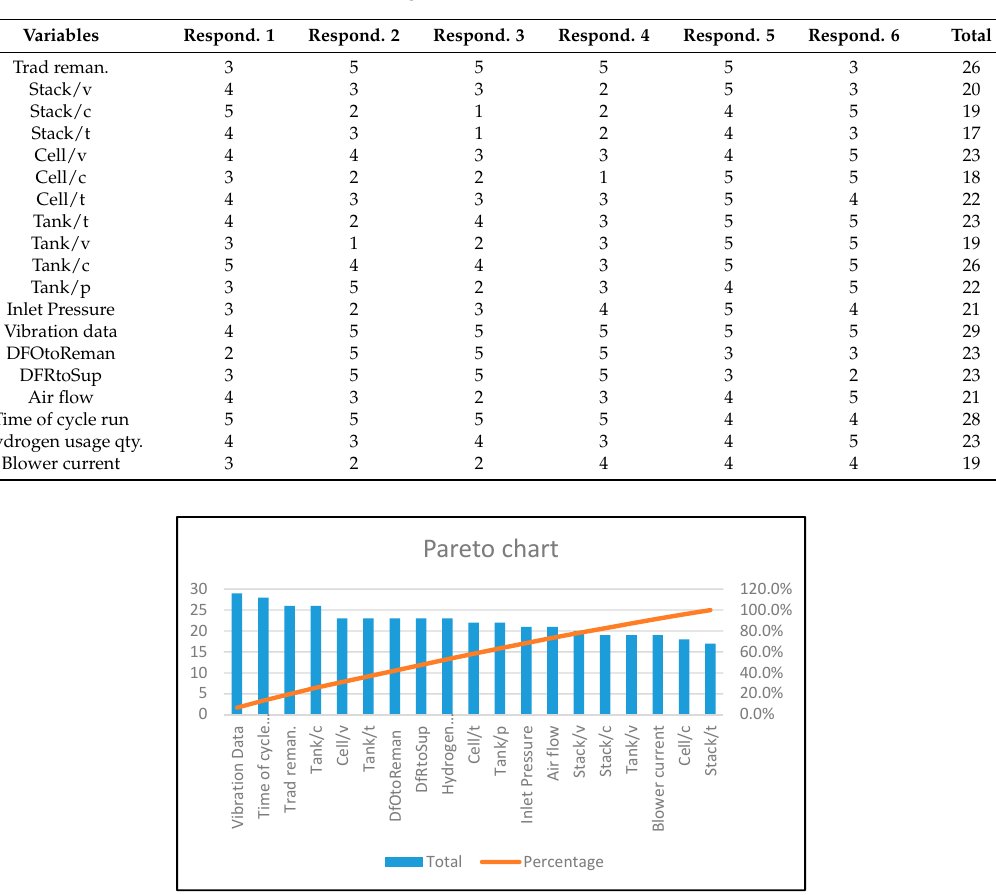
Table 3. Ranking of Parameters for Pareto Chart.